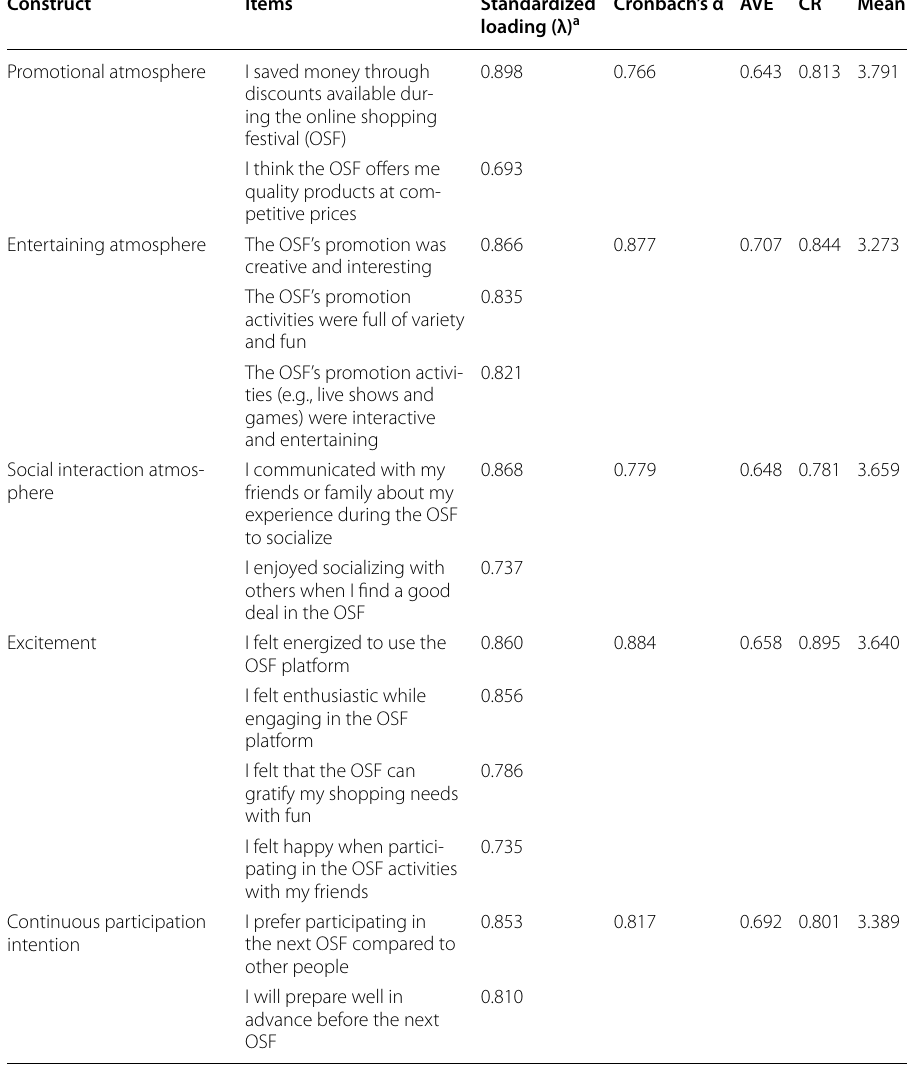
a All estimates are statistically significant at p < 0.01